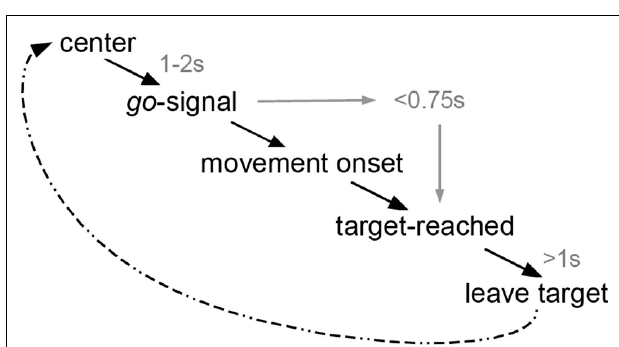
FIGURE 22 | (Data Set 3). Time course of a trial with time constraints (from Waldert et al., 2008 with